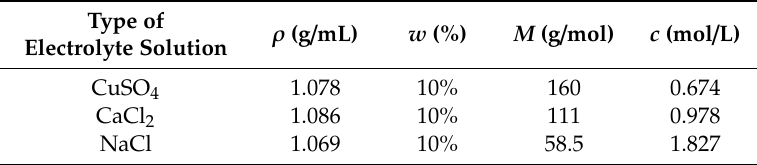
Table 11. Molarity of di ff erent